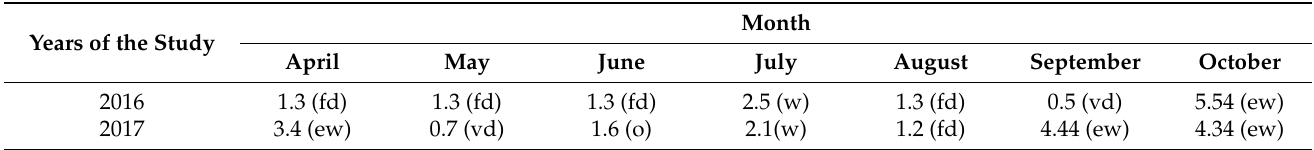
Table 1. The Selyaninov hydrothermal coefficient during the growing